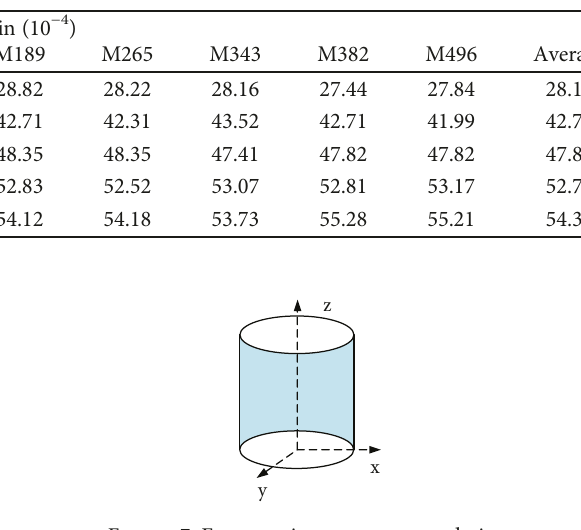
Figure 7: Fracture size measurement design.